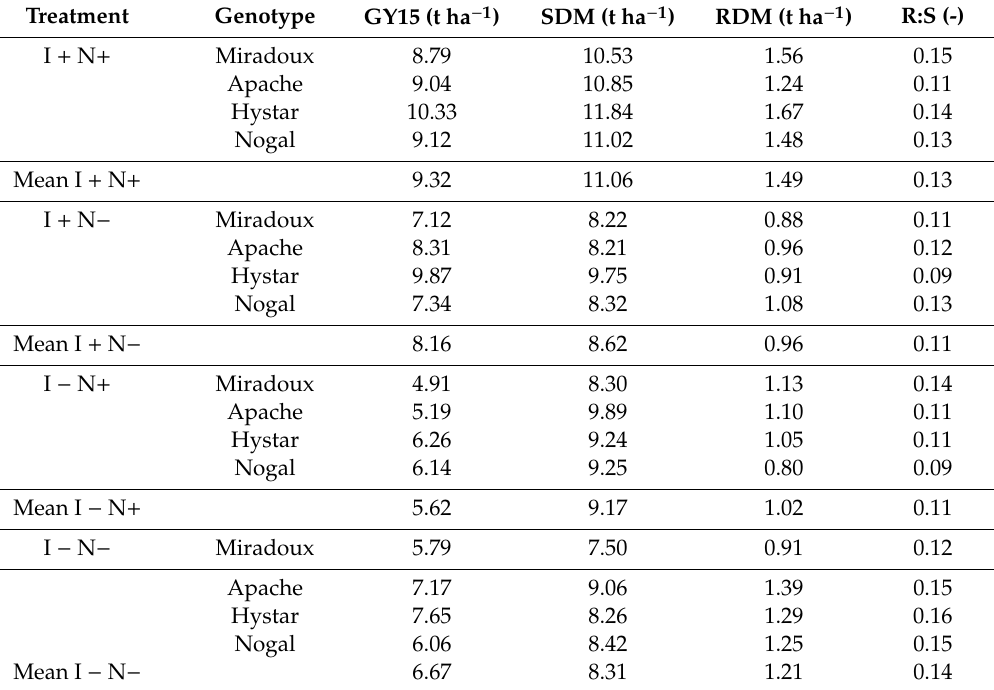
Table 1. Irrigation and Nitrogen (I, N) treatments e ff ect on root and shoot variables of wheat cultivars at anthesis. The table shows the mean values of plots at anthesis of shoot dry mass (SDM, t ha − 1 ), root dry mass (RDM, t ha − 1 ) and root to shoot ratio (R:S, dimensionless), and the grain yield (GY15, t ha − 1 ) at harvest.